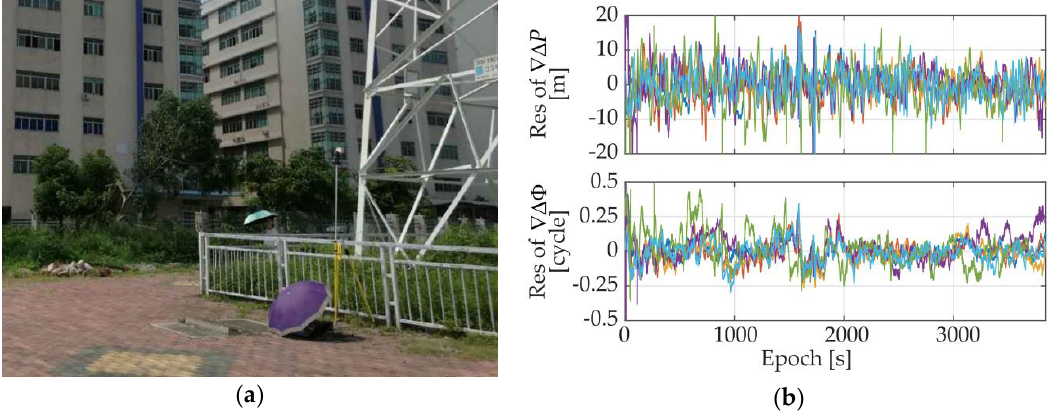
Figure 11. ( a ) Multipath environment; ( b ) DD measurement residuals under a multipath environment.